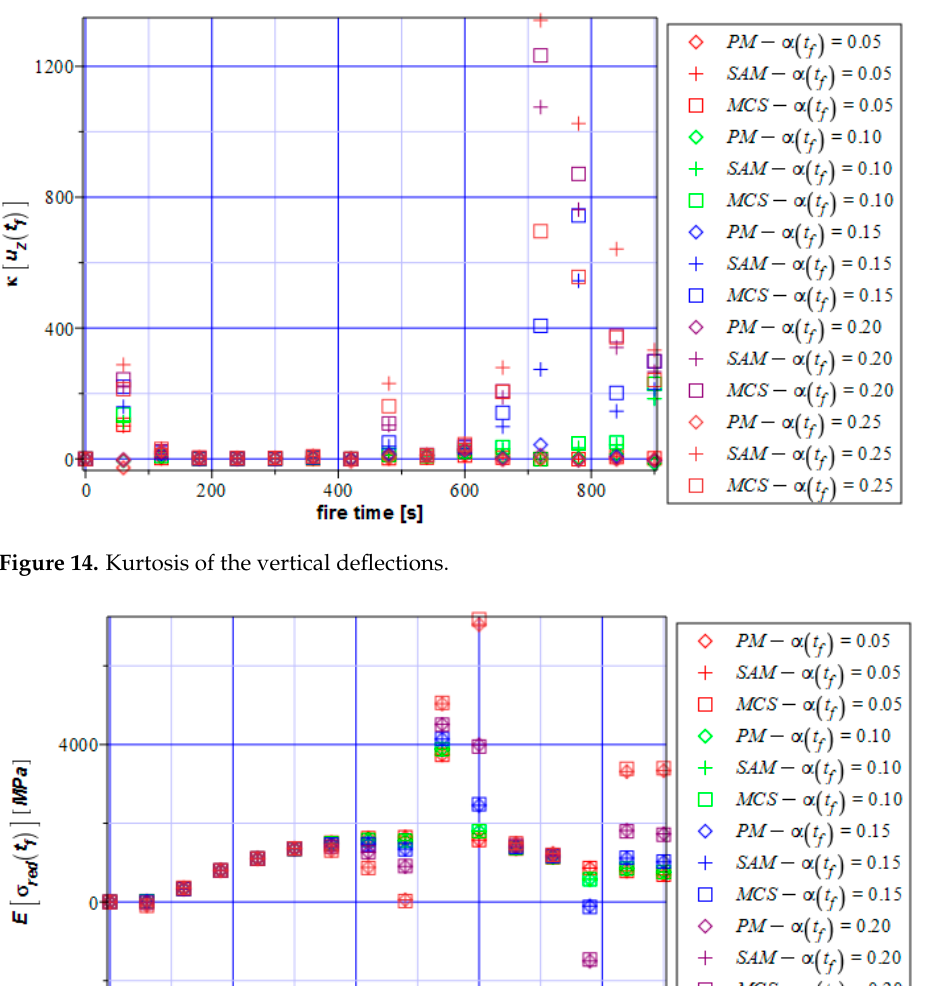
Figure 14. Kurtosis of the vertical deflections. Figure 13. The skewness of the vertical deflections.